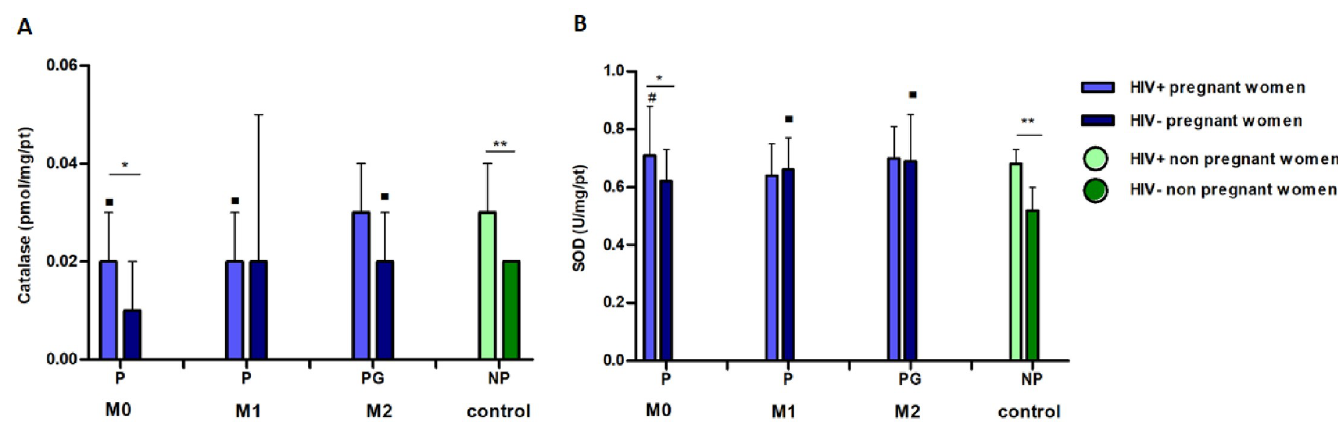
Fig 3. Factorial evaluation of antioxidant enzyme activity (superoxide dismutase [SOD] and catalase [CAT]) from the 39 included women. M0: moment zero (first or second trimesters), M1: moment one (third trimester), M2: moment two (post-partum). M0 and M1 P: pregnancy. M2 PG: postpartum Control NP: non-pregnant. NI: not infected, I: infected. A : M0 � G = i x ni p = 0 . 02 , - I = g x ng p = 0 . 01 . M1 - I = g x ng p = 0 . 004 . M2 - NI = pg x ng p = 0 . 01 . Control �� NG = I x ni p = 0 . 002 . B : M0 � G = i x ni p = 0 . 04 , M1- NI = g x ng p = 0 . 006 . M2 - NI = pg x ng p = 0 . 006 . Control �� NG = i x ni p = 0 . 004 . Statistical analysis : ANOVA followed by Tukey-Kramer post hoc tests (SOD) and Gamma Distribution (CAT)